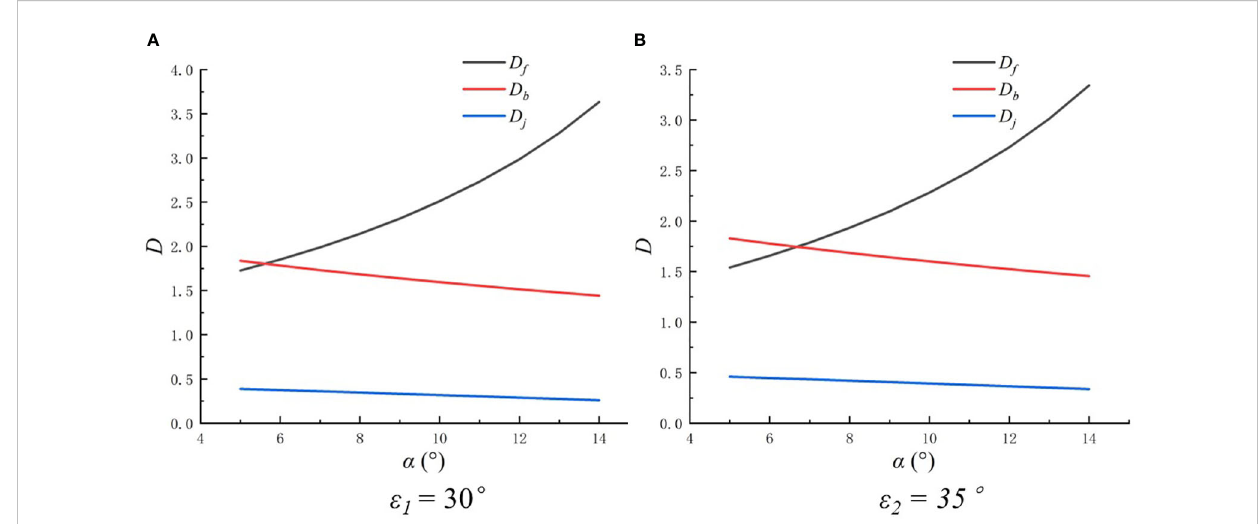
FIGURE 4 The shell fi sh motion index change curve under different horizontal swing direction angles: (A) ϵ 1 = 30°, (B) ϵ 2 =